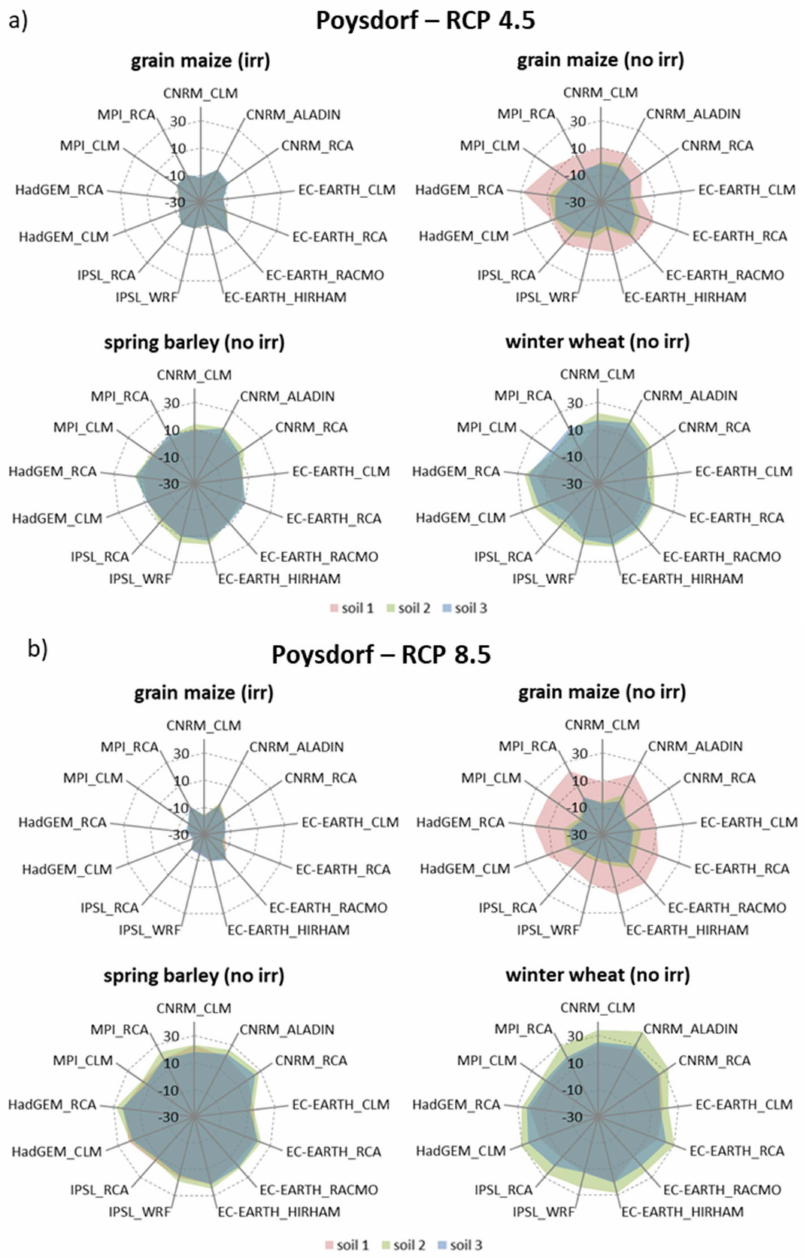
Figure 6. ÖKS15 projection-based simulated yield differences (2071–2100 vs. 1981–2010) for grain maize (optimal irrigated = irr; rainfed = no irr), spring barley (no irr), and winter wheat (no irr) for three different soil classes (soil 1 = pink, soil 2 = green, soil 3 = blue) (RCP 4.5 ( a ) and RCP 8.5 ( b )) at Poysdorf weather station